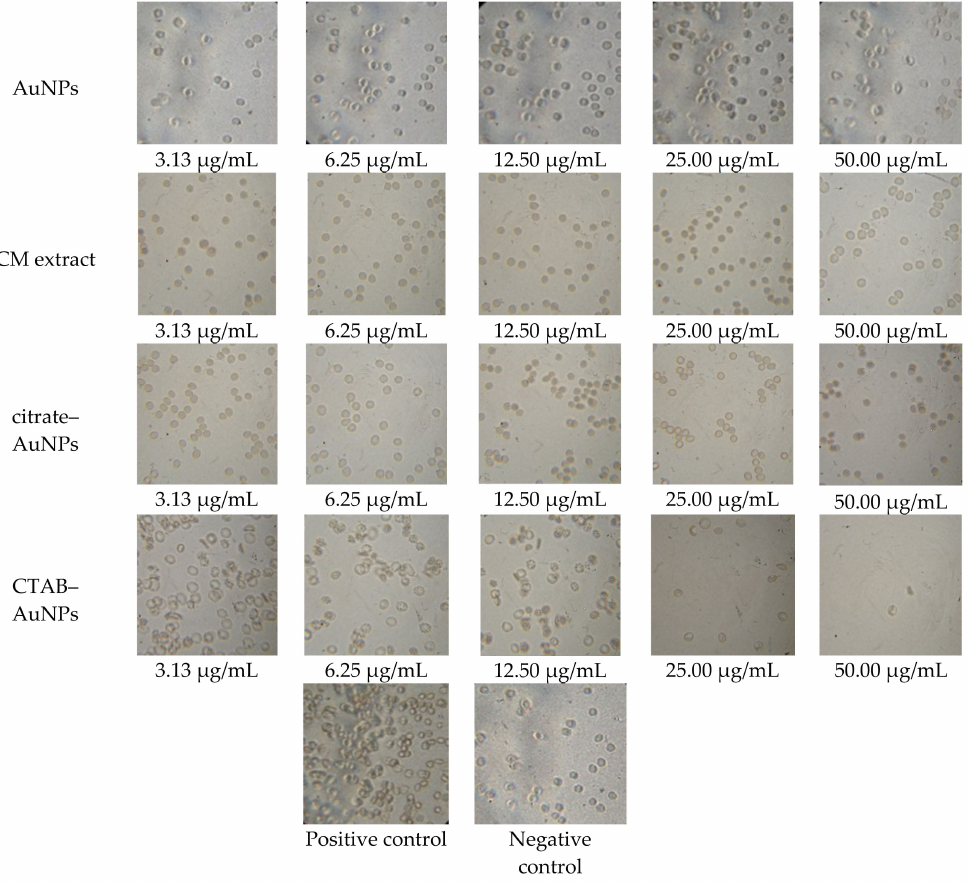
Figure 7. Micrographs of erythrocytes after 2 h of incubation with the positive control, the negative control, the AuNPs, the CM extract, the citrate-AuNPs, and cetyltrimethylammonium bromide (CTAB)-AuNPs at concentrations of 3.13, 6.25, 12.50, 25.00, and 50.00 µ g/mL at a magnification of 100 ×